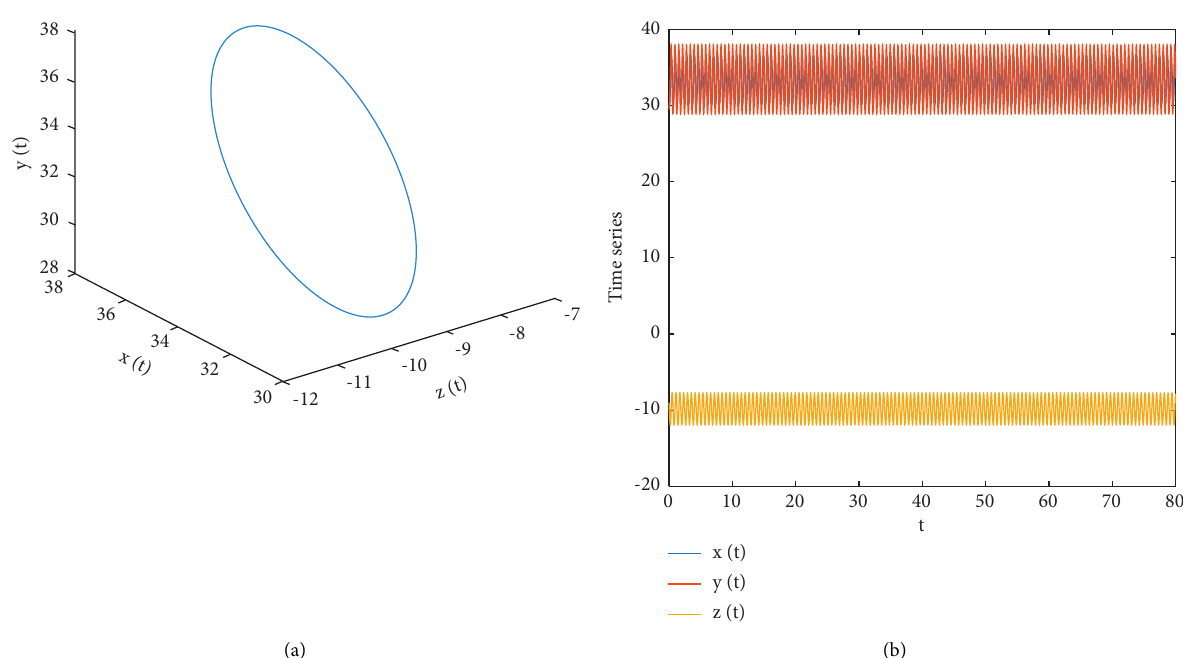
Figure 3: A bifurcation diagram for system (1) with parameter values ( a,b, c, k,k ( 30 , 30 , − 9 ) when τ � 0 . 2095 < τ 0